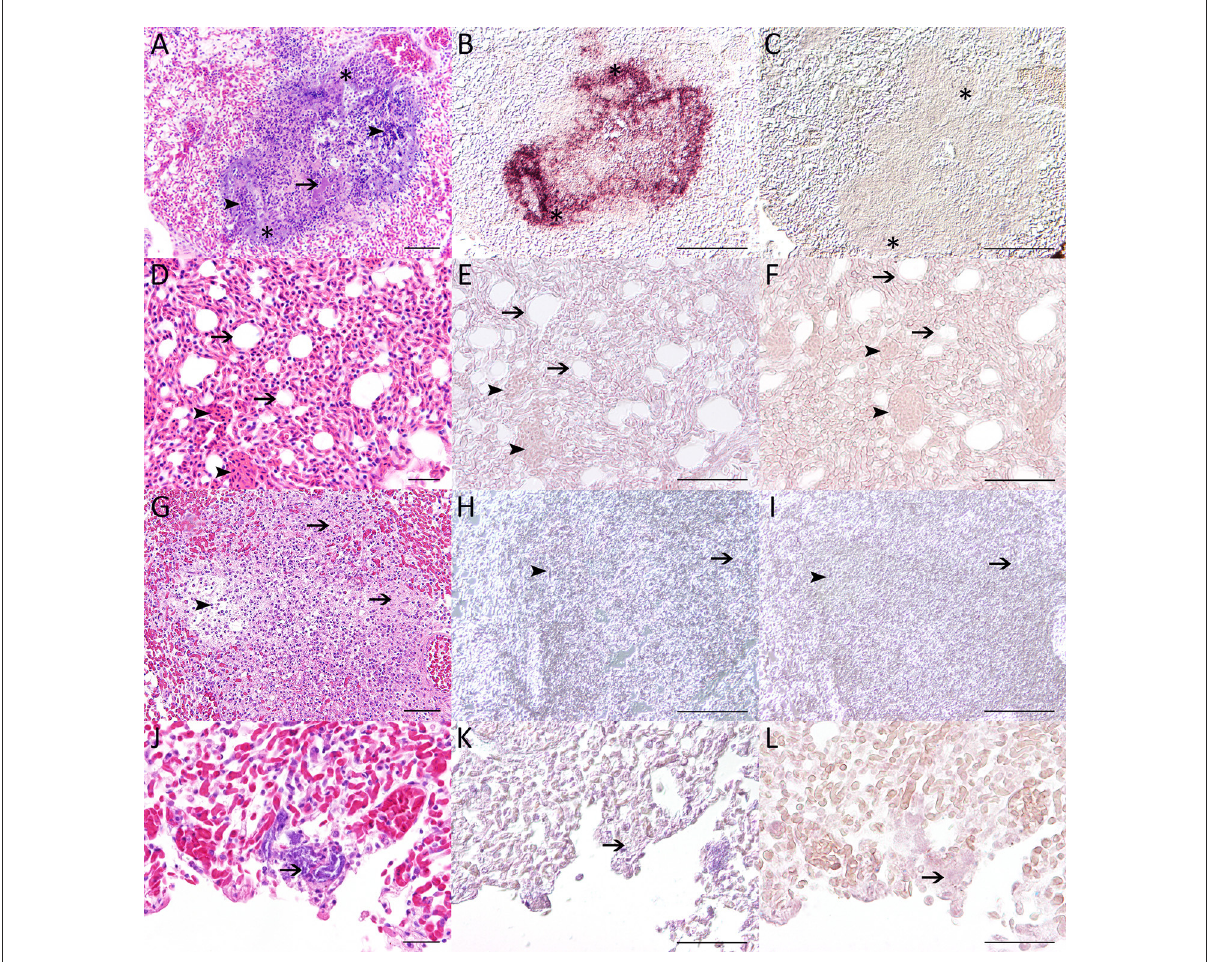
FIGURE1 Pictures show hematoxylin and eosin stain (A,D,G,J) , in situ hybridization using the anti- Suttonella in situ probe (B,E,H,K) and results after incubation with hybridization buffer only (C,F,I,L) . Pulmonary lesions within an affected tit [case 2; (A–C) ] characterized by severe loss of organotypical architecture with accumulation of cellular debris (arrow) and inflammatory cells (arrowheads) as well as intralesional bacteria (asterisks). Necrotizing lesions with intralesional bacteria within the lung tissue of the affected animal show a strong positive reaction (purple precipitate; asterisks) in in situ hybridization (B) . Lung tissue of the negative control tit [case 6; (D–F) ] consisting of regularly structured pulmonary tissue with air capillaries (arrows) and blood vessels (arrowheads). Pulmonary lesion of the cattle egret (case 7) suffering from salmonellosis displaying a focus of severe, fibrino-necrotizing pneumonia (G–I) with cellular deposition of debris and fibrinous material (arrow), inflammatory cells (arrowheads) and multifocal bacterial emboli [arrow; (J–L) ]. No hybridization signal was detected within the lung of the negative control tit [ (E) ; air capillaries: arrows; blood vessels: arrowheads] and the pulmonary lesions of the cattle egret [ (H) ; debris and fibrinous material: arrow; inflammatory cells: arrowhead]. In addition, no signals were detected without using the DNA probe but hybridization buffer only (C,F,I) —the respective areas of interest are correspondingly marked with asterisks, arrows and arrowheads (C,F,I) . Pictures displaying in situ hybridization were taken using differential contrast (Nomarski) microscopy. Bars: 20 µ m: (D) ; 50 µ m: (A,E–G) ; 100 µ m: (B,C,H,I) .